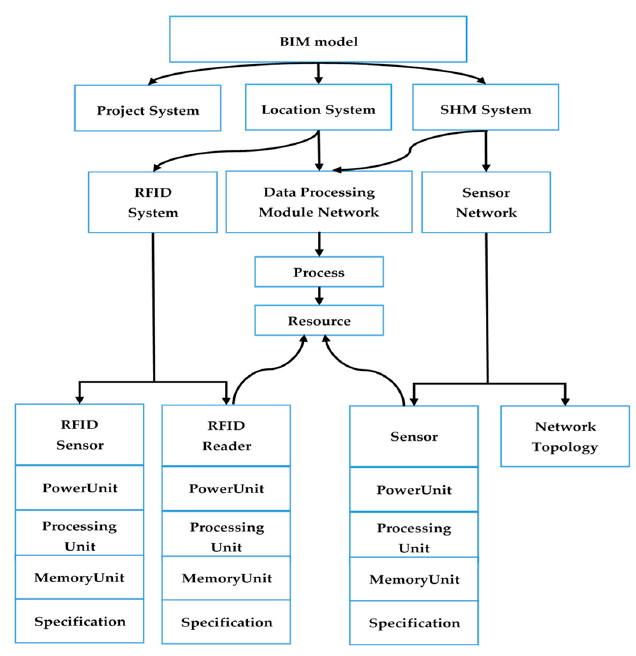
Figure 7. BIM model framework.